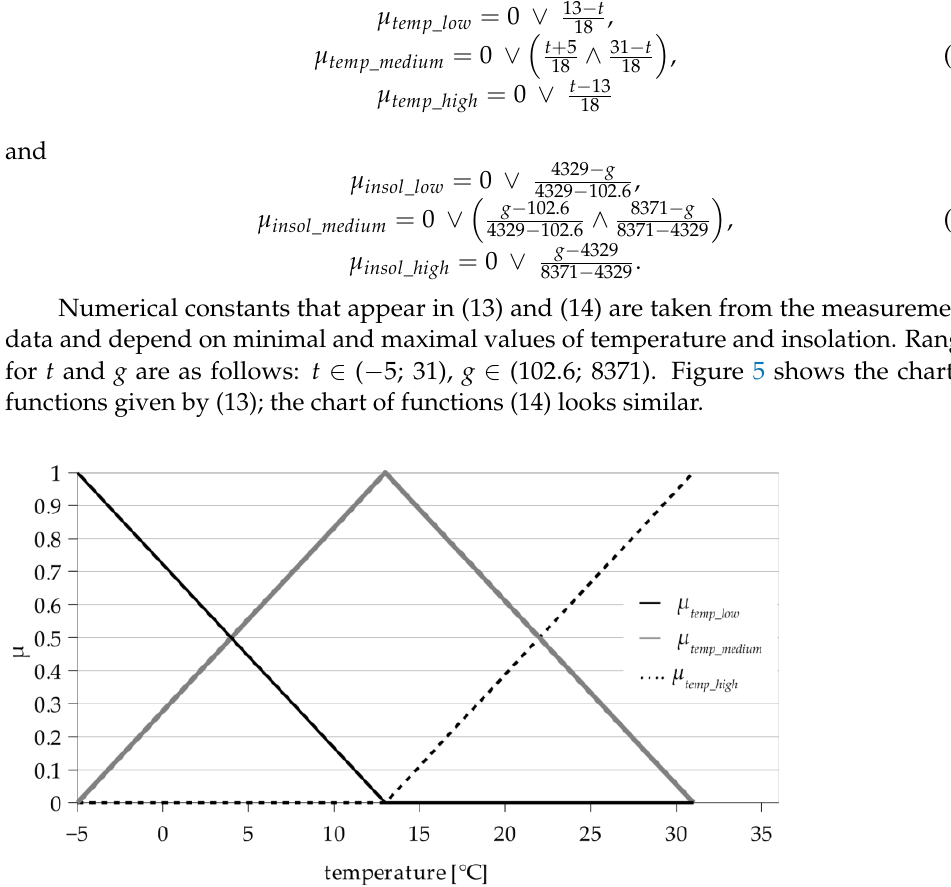
Figure 5. The chart of membership functions of Equation (13).